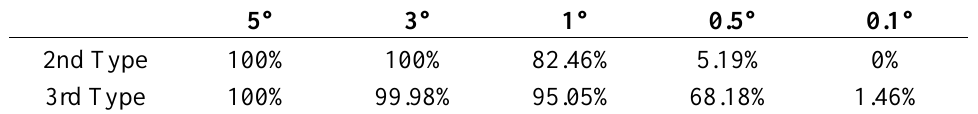
Table 1. Success rates with the 2nd or 3rd type measurement error considered